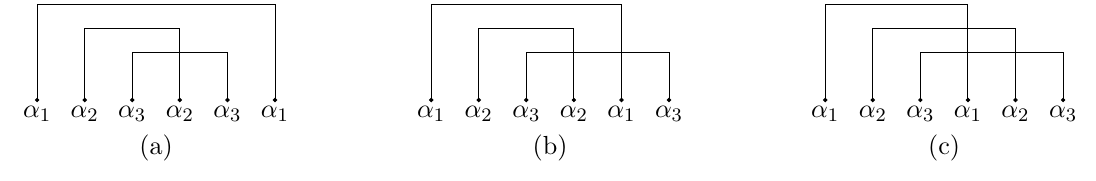
Figure 1 . Three contraction diagrams contributing to the sixth